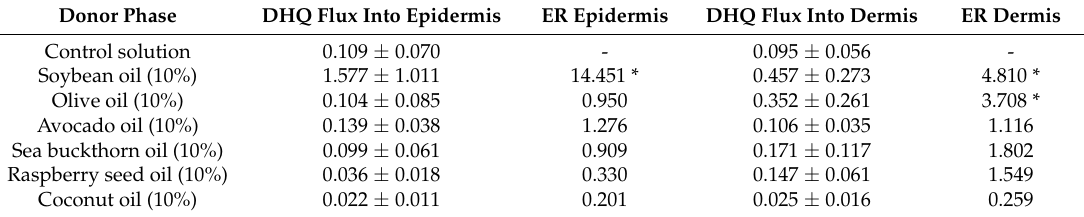
Table 2. Dihydroquercetin flux into human epidermis and dermis, and enhancing ratios of natural oils (n =